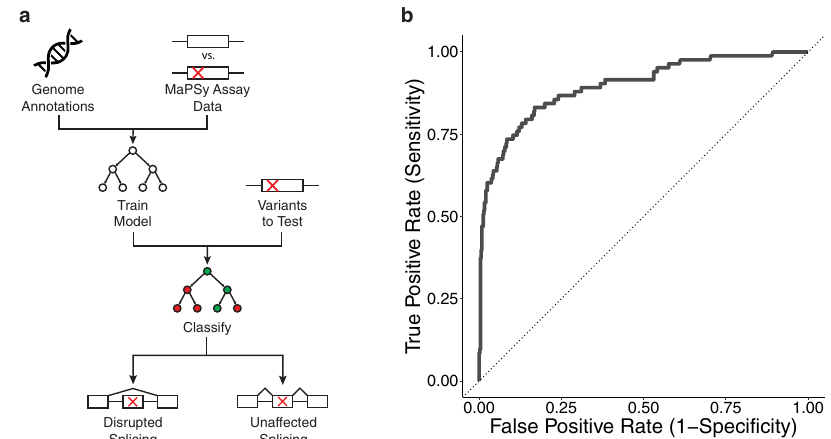
Fig. 1 Prediction work fl ow. a Computational pipeline of the GBM classi fi er. The classi fi er is composed of features extracted from genomic sequence and features related to variants tested by MaPSy. b Receiver – operator characteristic (ROC) curve for the GBM classi fi er.